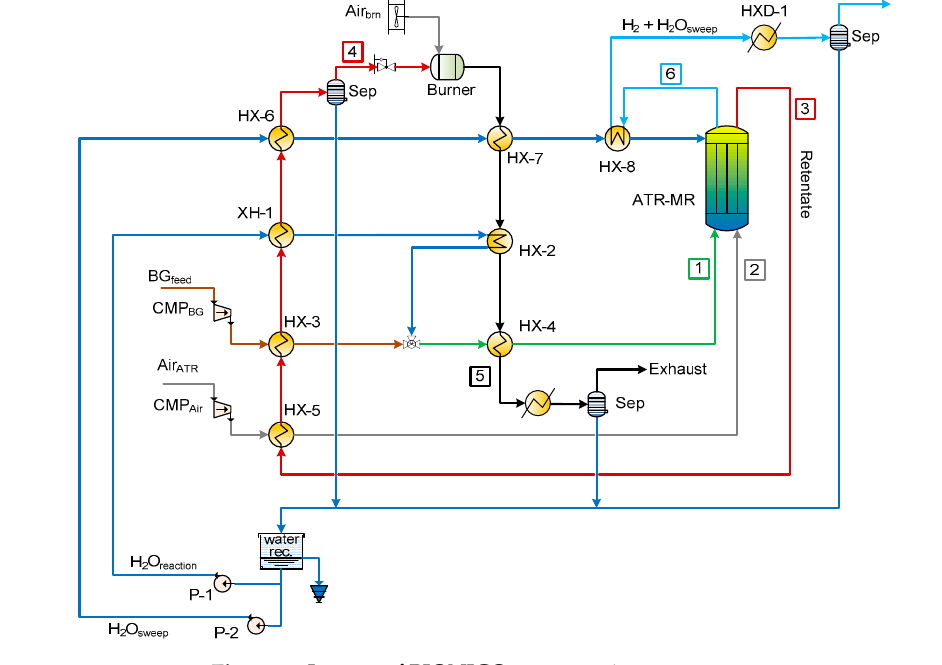
Figure 8. Layout of BIONICO system using sweep gas. Figure 8 Layout of BIONICO system using sweep gas. Table 6. Stream properties at in / exit of reactors (@pressure and Table 6 Stream properties at in/exit of reactors (@pressure and T).